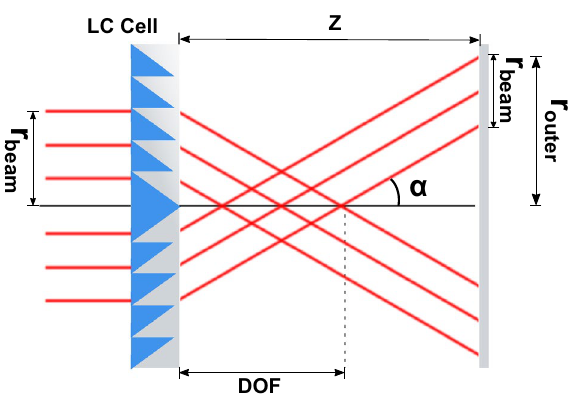
Figure 2. Blazed axicon ray diagram showing relevant